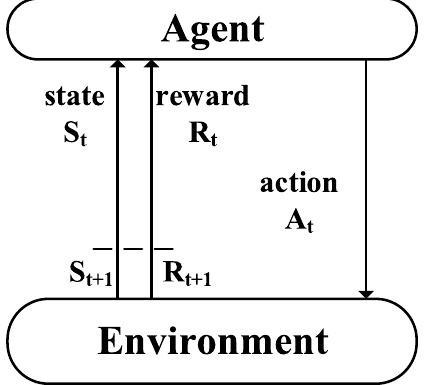
Figure 1. Reinforcement learning